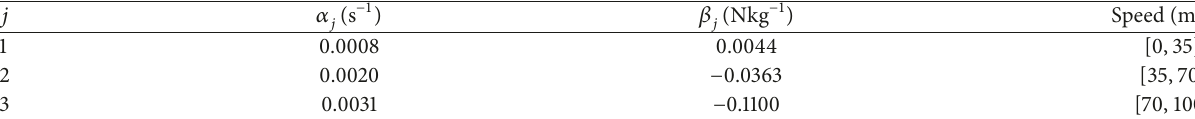
Table 2: The piecewise linear parameters of basic resistance.